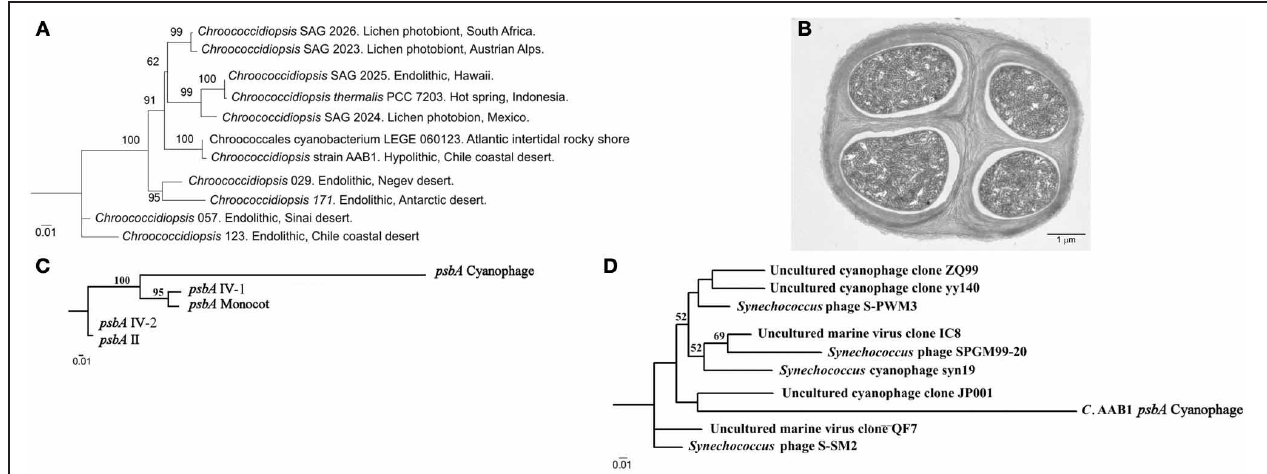
FIGURE 6 | 16S rDNA Maximum Likelihood phylogenetic tree of select Chroococcidiopsis 16S rDNA sequences. (A) 16S rDNA cyanobacterial sequences. Sequences were aligned by Multiple sequence comparison by log-expectation and then analyzed by the PhyML tool of Bosque Phylogenetic Analysis software (Ramírez-Flandes and Ulloa, 2008). Numbers close to the nodes represent 1000 replicate Bootstrap values. Only species shown in Figure 2 of Fewer et al. (2002) were considered for comparison purposes. (B) Transmission electron microscopy micrograph showing the typical ultrastructure of a tetrad of Chroococcidiopsis strain